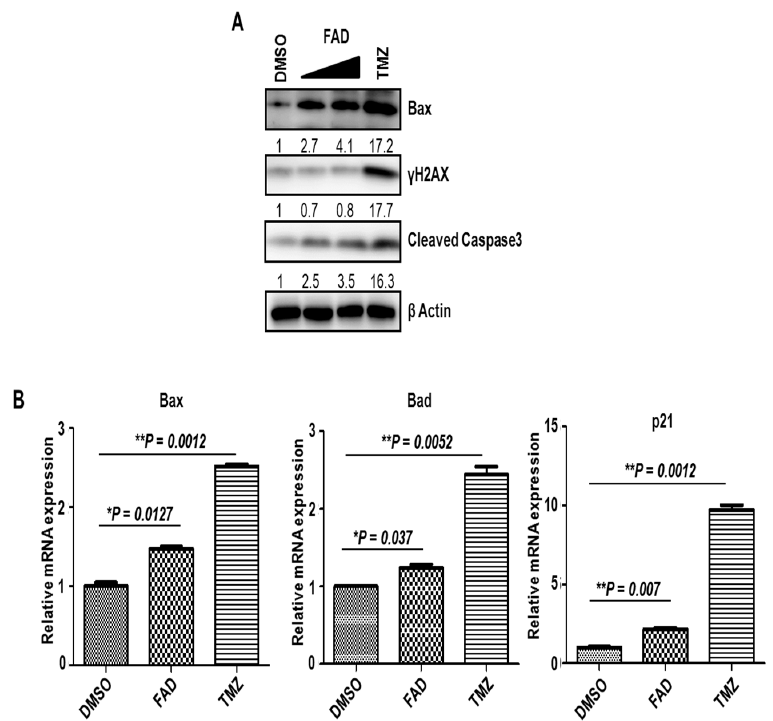
Figure 1. Cytotoxicity driven by falcarindiol (FAD) on glioblastoma cells. ( A ) Western blot analysis of Bax, γ H2AX, and cleaved caspase 3 in U373 glioblastoma cells after treatment of dimethyl sulfoxide (DMSO), FAD (10 µ M, 40 µ M), and TMZ (200 µ M) for 3 days. β Actin was used as a loading control. The relative band intensities of each proteins are shown below the bands. The intensities of vehicle treated lane were arbitrarily set as 1. ( B ) The mRNA expression of Bax, Bad, and p21 after treatment of DMSO, FAD (40 µ M), and TMZ (200 µ M) for 3 days in glioblastoma cells, as measured by real-time reverse transcription-polymerase chain reaction (RT-PCR) analysis. The mRNA level of DMSO-treated cells was set to 1. Representative results from multiple experiments are